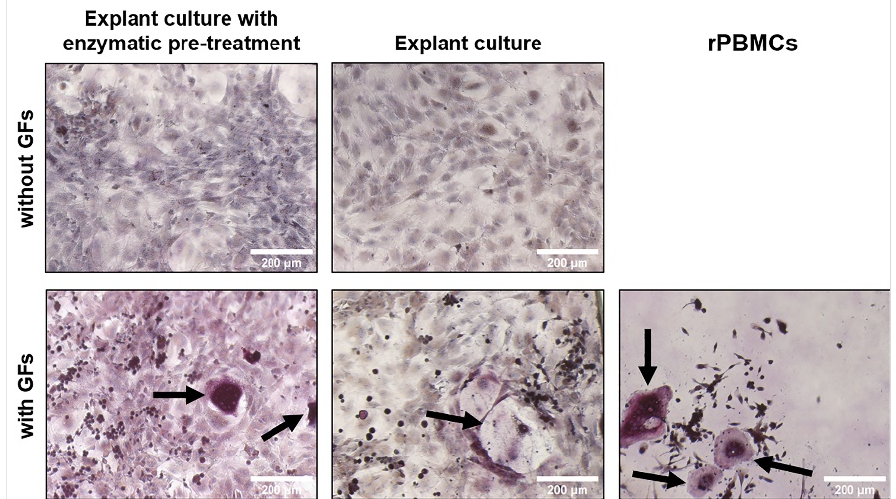
Figure 6. TRAP staining in co-cultures of rPBMCs and rOBs isolated either by explant culture or explant culture with enzymatic pre-treatment on day 7. Cells were cultured with or without exoge- nous GFs (M-CSF, RANKL). rPBMCs served as a control of osteoclastogenesis and were cultured only with exogenous GFs. TRAPs were stained by a TRAP kit and nuclei were stained by hematox- ylin. Black arrows show formed rOCs. Magnification 100×, scale bar 200 μ m.